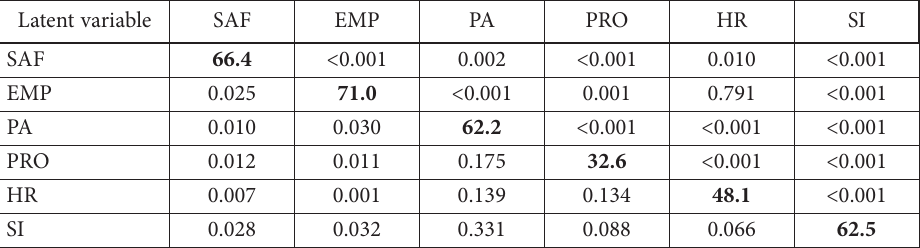
Table 4. AVE values (in the main diagonal) and Fornell – Larcker test of discriminant